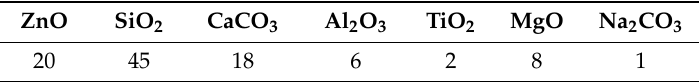
Table 1. Composition of ZnO-SiO 2 -CaO glass (wt